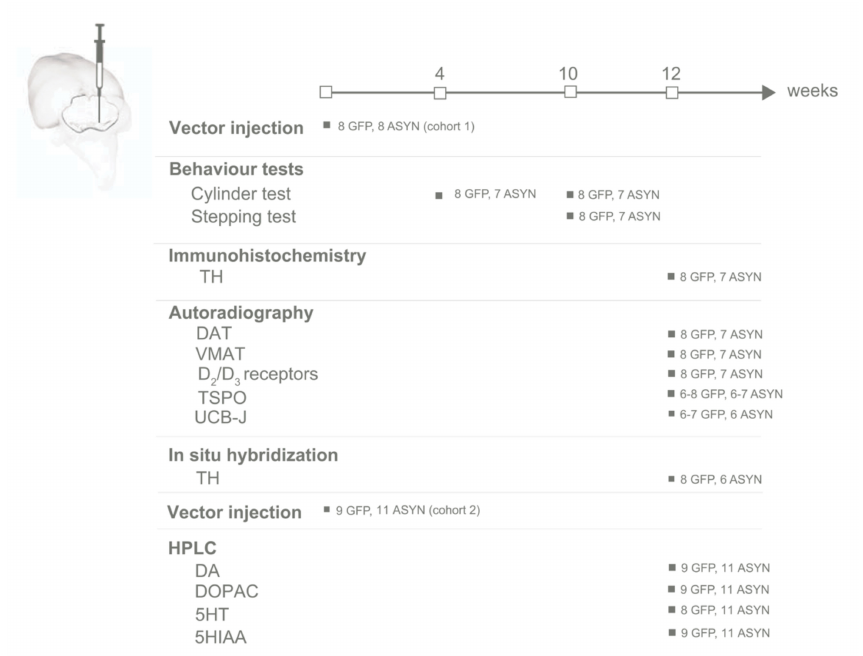
Figure 1. Timeline of studies. Two rat cohorts were injected with rAAV, containing either ASYN or GFP. In cohort 1 ( n = 8 per group), behavioral tests were conducted at 4- and 10-weeks post-injection, and post-mortem immunohistochemistry and autoradiography at week 12 post-surgery. Cohort 2 (11 ASYN and 9 GFP) was used for HPLC